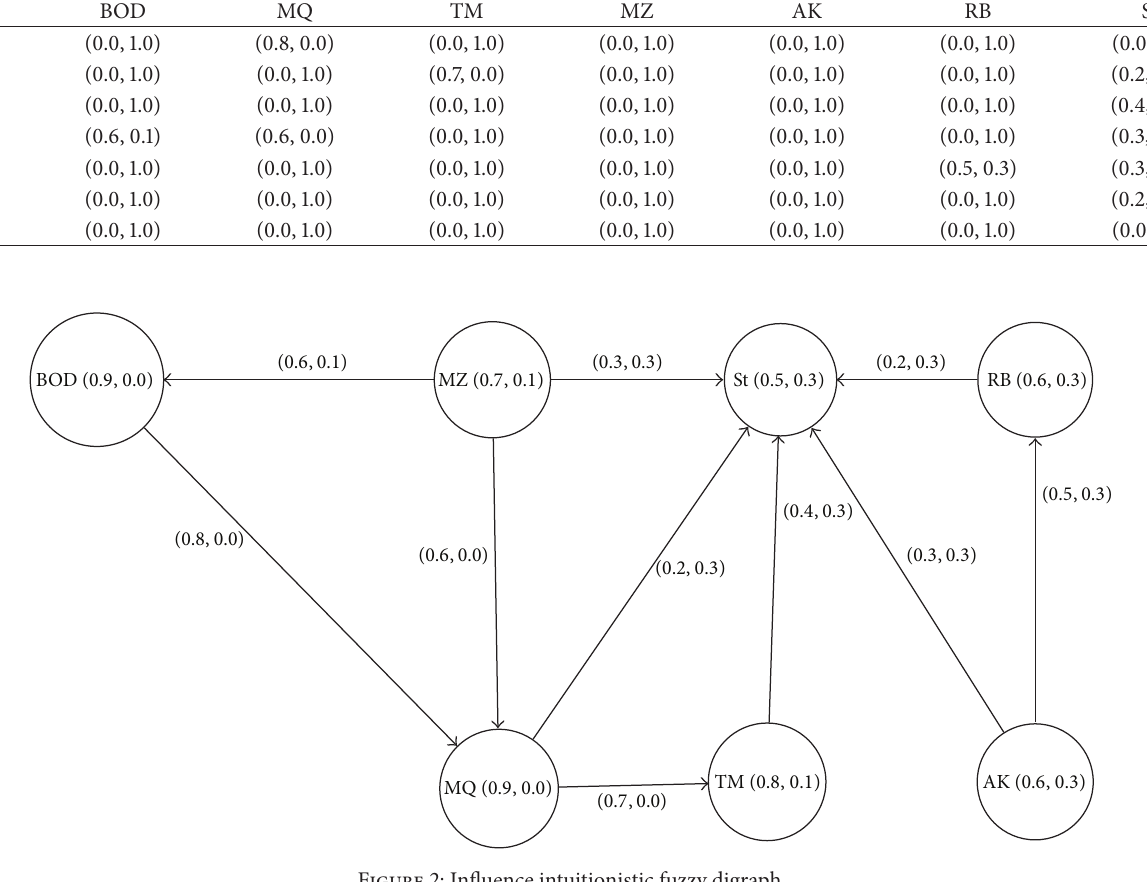
Figure 2: Influence intuitionistic fuzzy